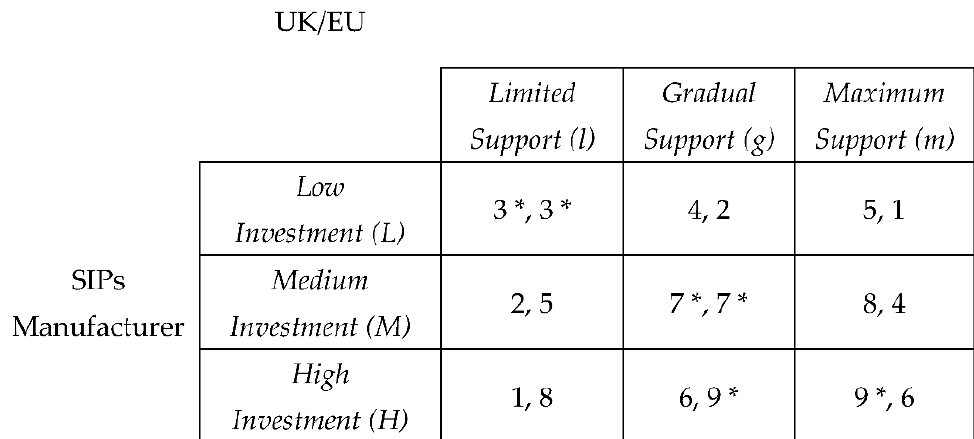
Figure 6. Simultaneous game payoff matrix.